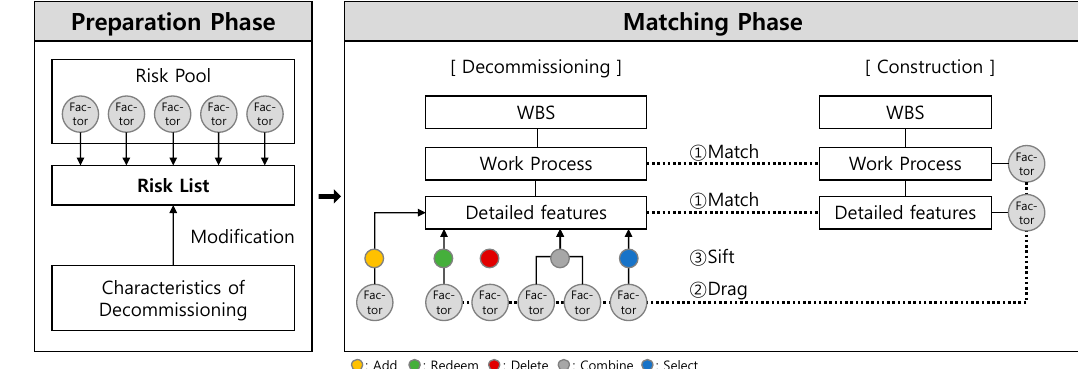
Figure 2. Risk identification step process.